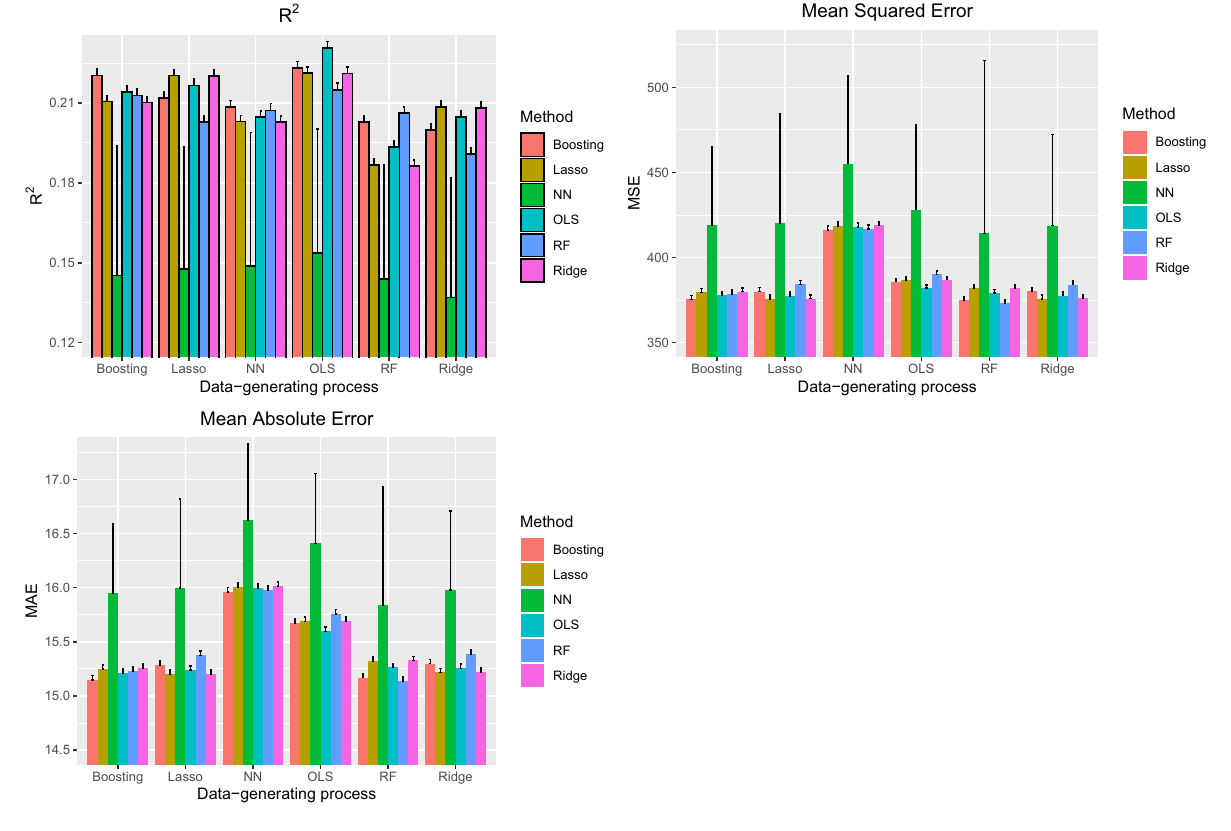
Figure 3. Performance in CHF sample (External